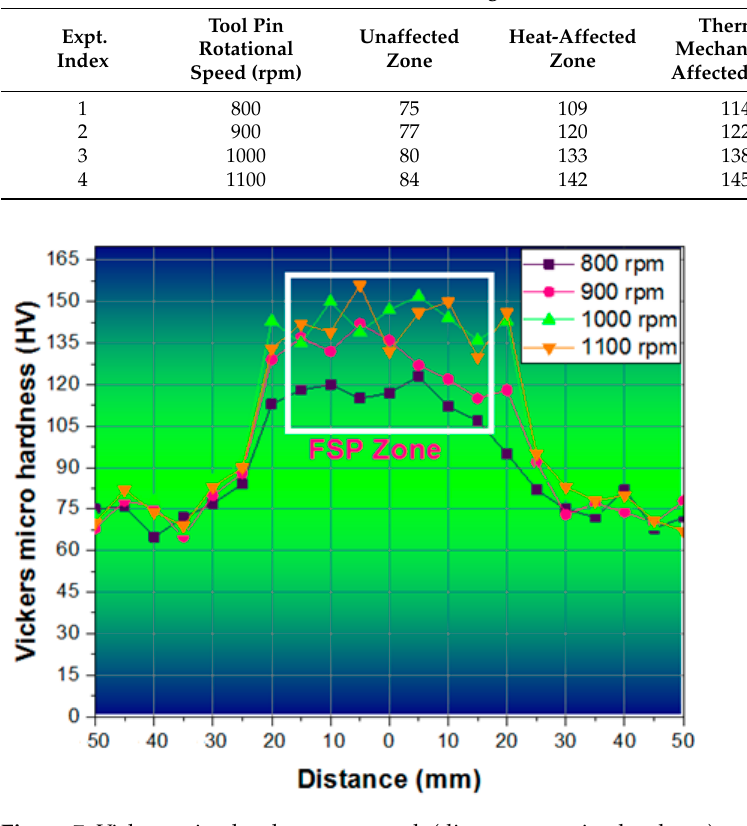
Figure 7. Vickers microhardness test graph (distance vs. microhardness).